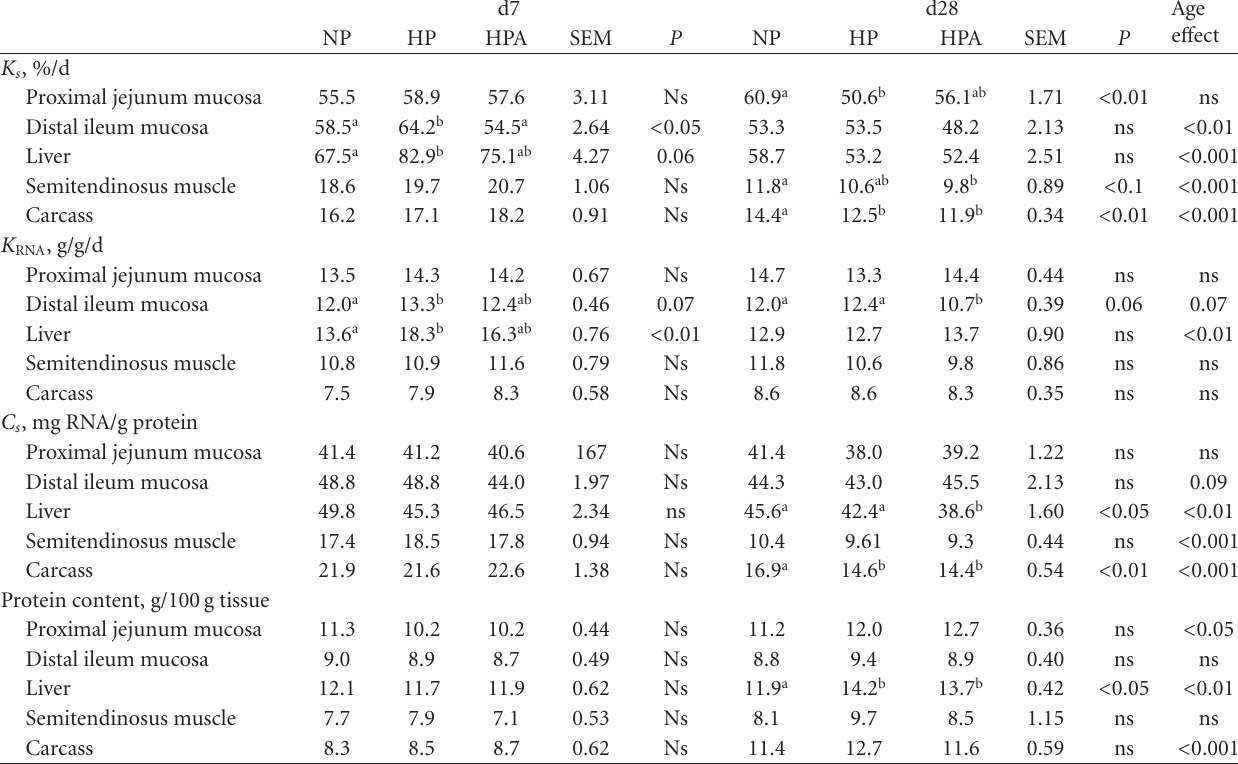
Table 5: Fractional rates ( K s , %/d) of protein synthesis, protein synthesis e ffi ciency ( K RNA ), ribosomal capacity ( C S ) and protein contents (g/100g tissue) measured in various tissues of piglets fed NP, HP, and HPA diets at d7 and d28.